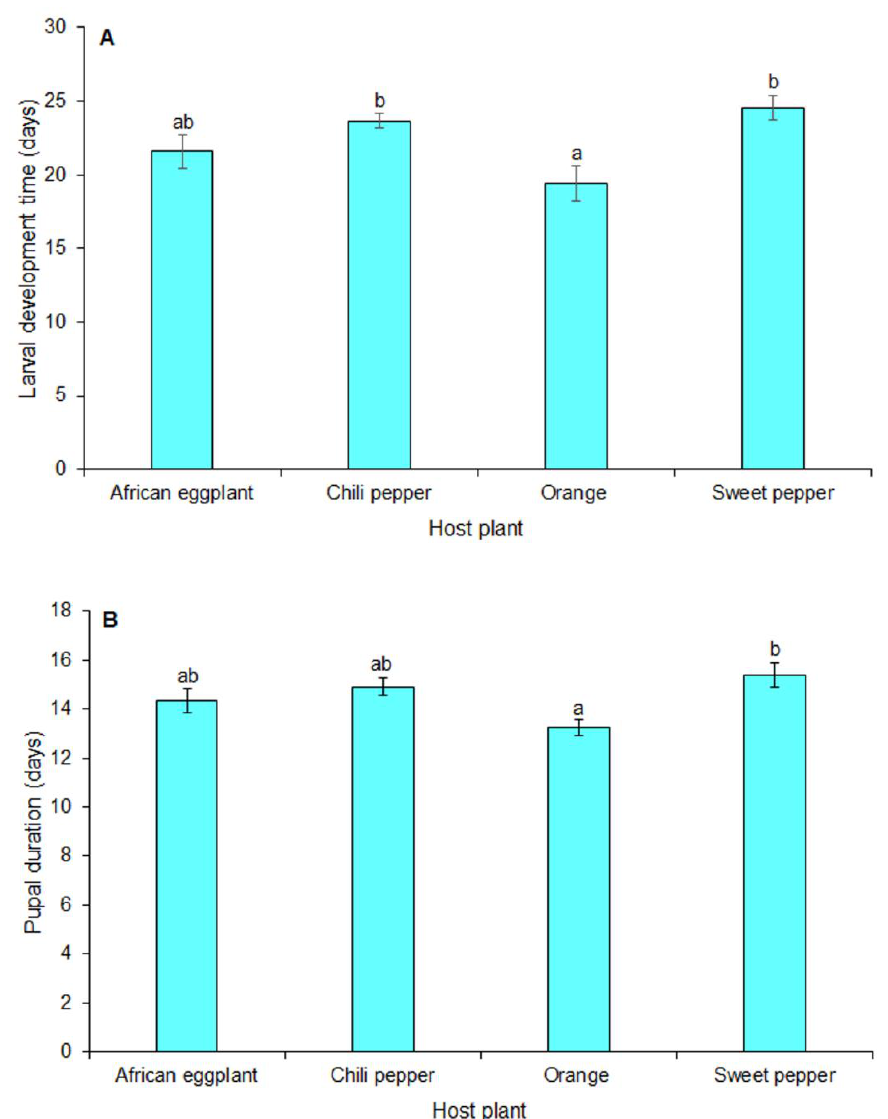
Figure 3. Mean development times ( ± SE) of Thaumatotibia leucotreta larvae ( A ) and pupae ( B ) on orange and solanaceous vegetables. Bars caped by the same letter are not significantly different ( p = 0.05, Tukey’s HSD).